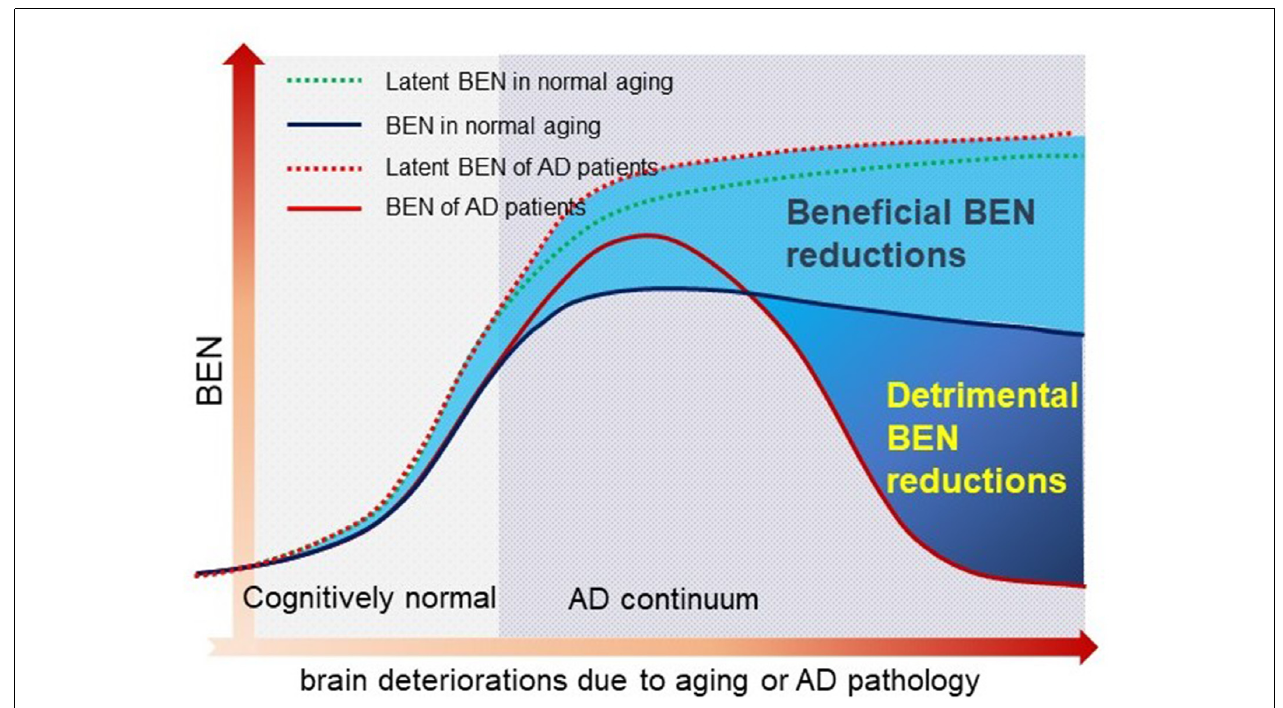
FIGURE 1 | A hypothetical brain entropy (BEN) model for normal aging and Alzheimer’s disease (AD). The dotted line shows the latent BEN evolution trend as a result of the aging-related accumulated brain deteriorations. The dashed line represents the actual BEN evolution curve after brain reserve compensation which imposes negative entropy brings down the total BEN. Catastrophic BEN reduction may start at the disease conversion time due to a potential overaction of the brain